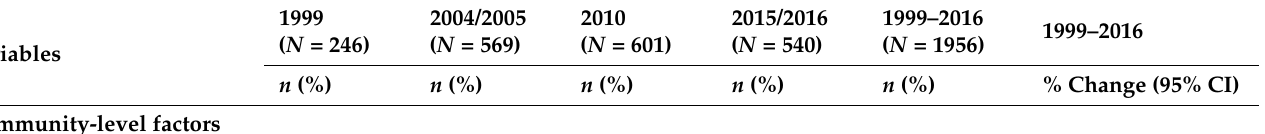
Table 3. Prevalence of unmet need for limiting